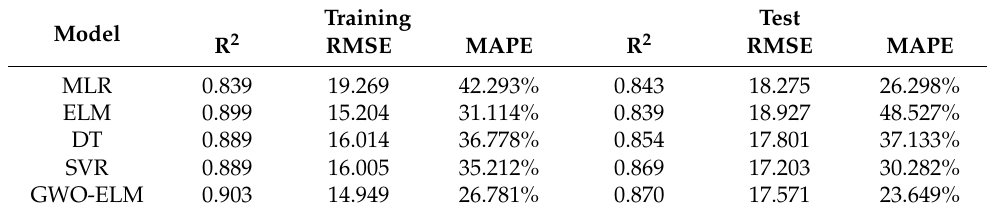
Figure 11. Prediction results of training and test stages for different models for E. Table 3. Evaluation index of different models for